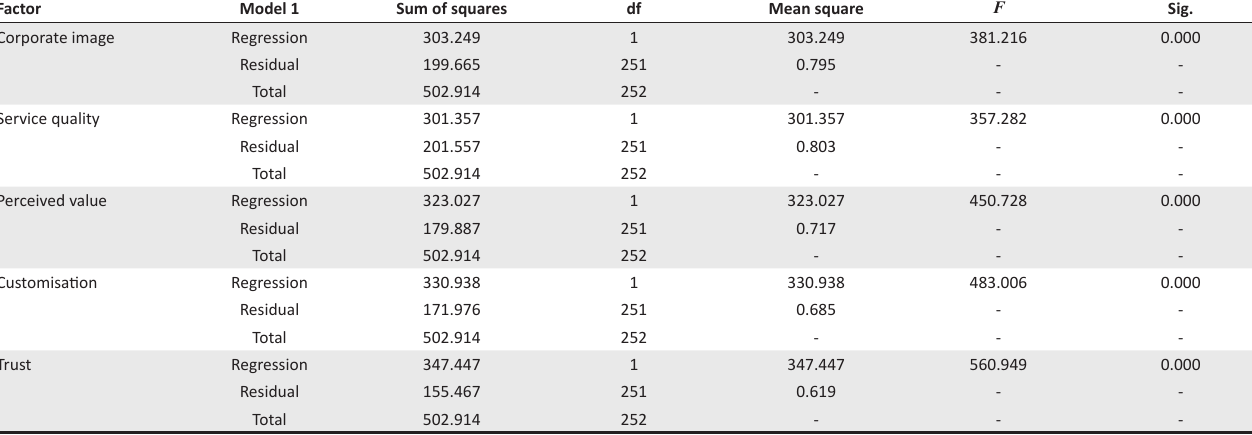
TABLE 3b: Influence of the independent variables on the dependent variable. ANOVA.